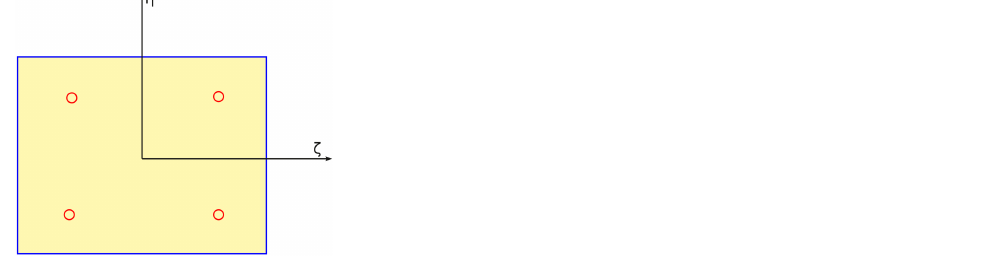
Figure 3. Gauss quadrature diagram on the vortex panel (the red circles stand for the Gauss quadra- ture points).